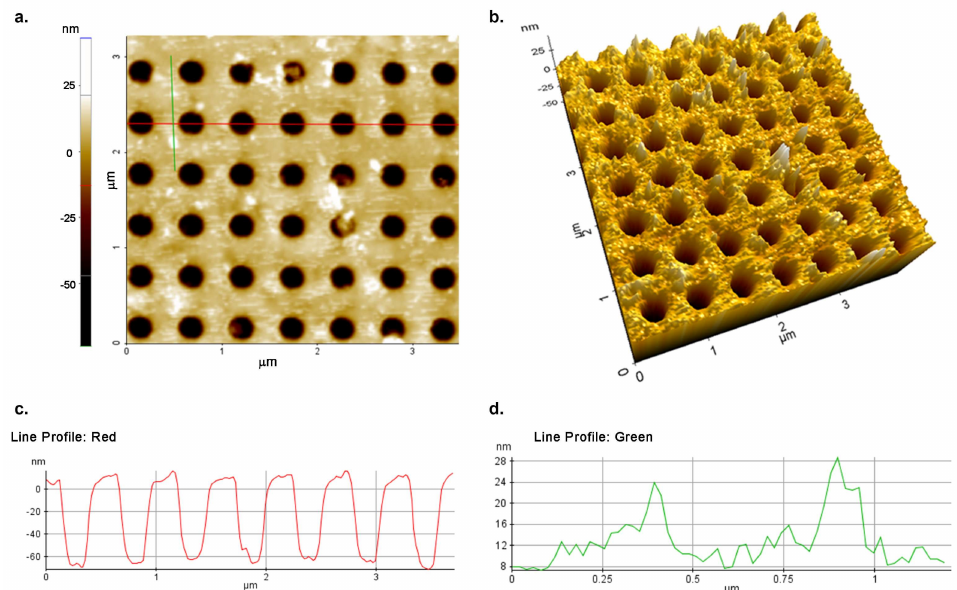
Figure 5. Atomic force microscopy (AFM) images and line profile of the functionalized PhC surface. Figure ( a , b ) reveal the presence of the p53 • MDM2 complex over the PhC surface. The red profile ( c ) corresponds to the red line drawn over a row of holes, showing their cross-section, the green profile ( d ) to the green line drawn in an area containing